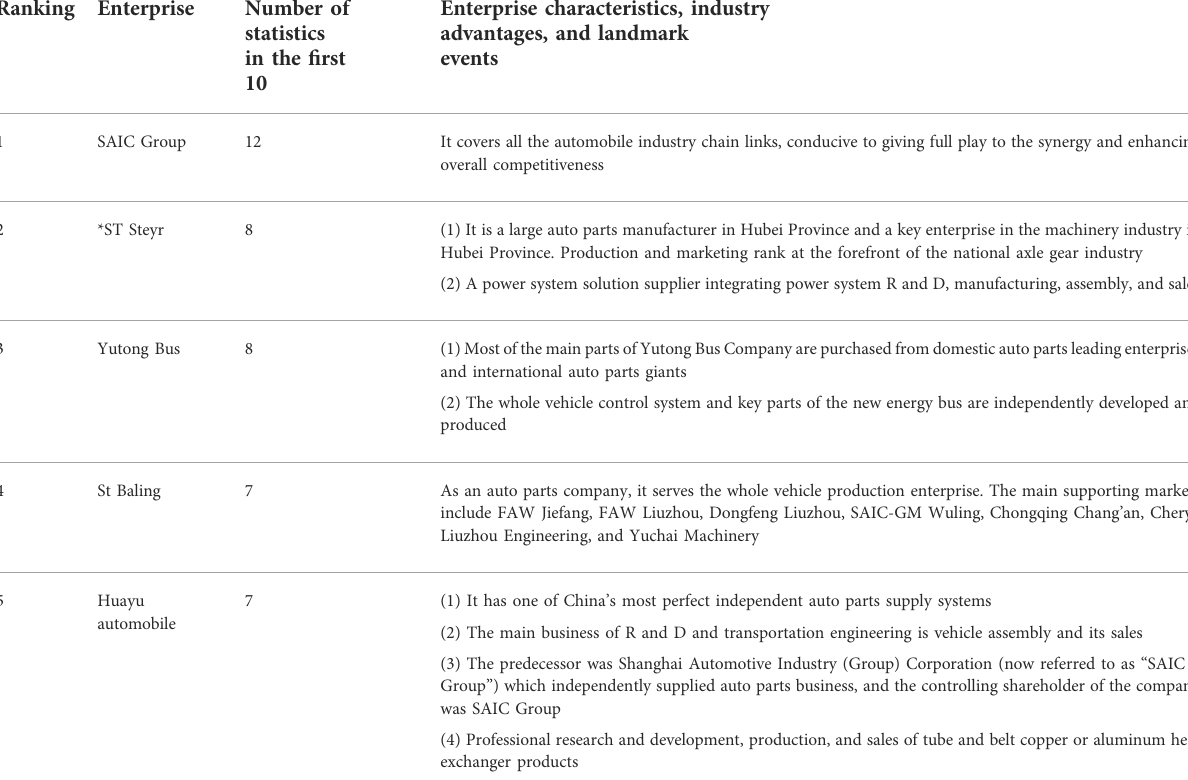
TABLE 6 Statistics of top 10 network betweenness in China ’ s auto fi nance market from 2012 to 2020. Ranking